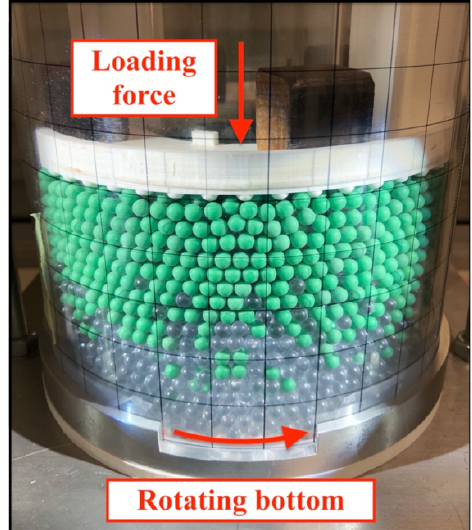
Fig. 1. Photograph of the experimental setup. The annular shear cell is characterized by a rotating bumpy bottom and a loaded top wall that provides confinement. The system is filled with a 50/50 mix of grains by volume.